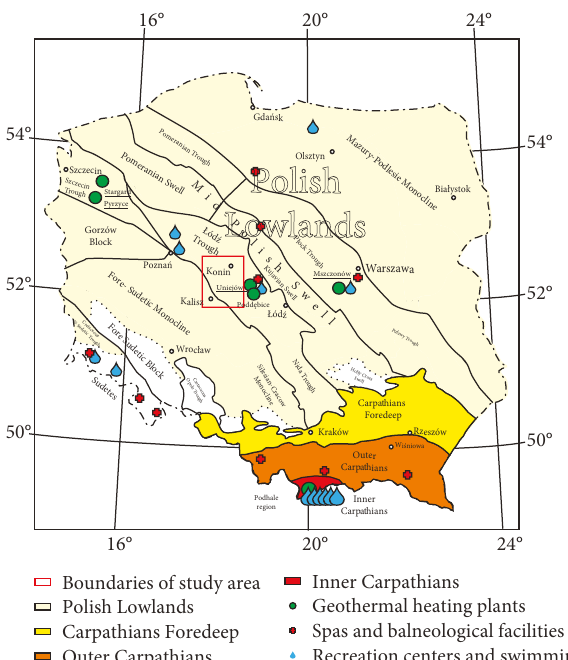
Figure 1: Geological regional division of Poland without Cenozoic cover with location of geothermal installations (after [4], modi fi